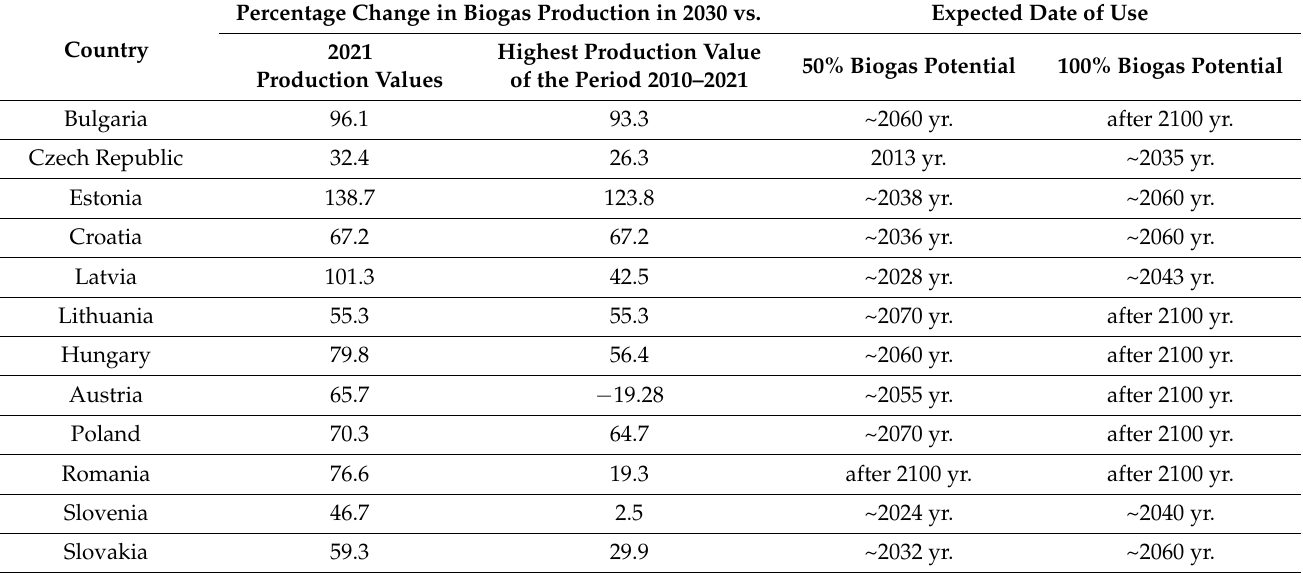
Table 2. Biogas production forecast based on four